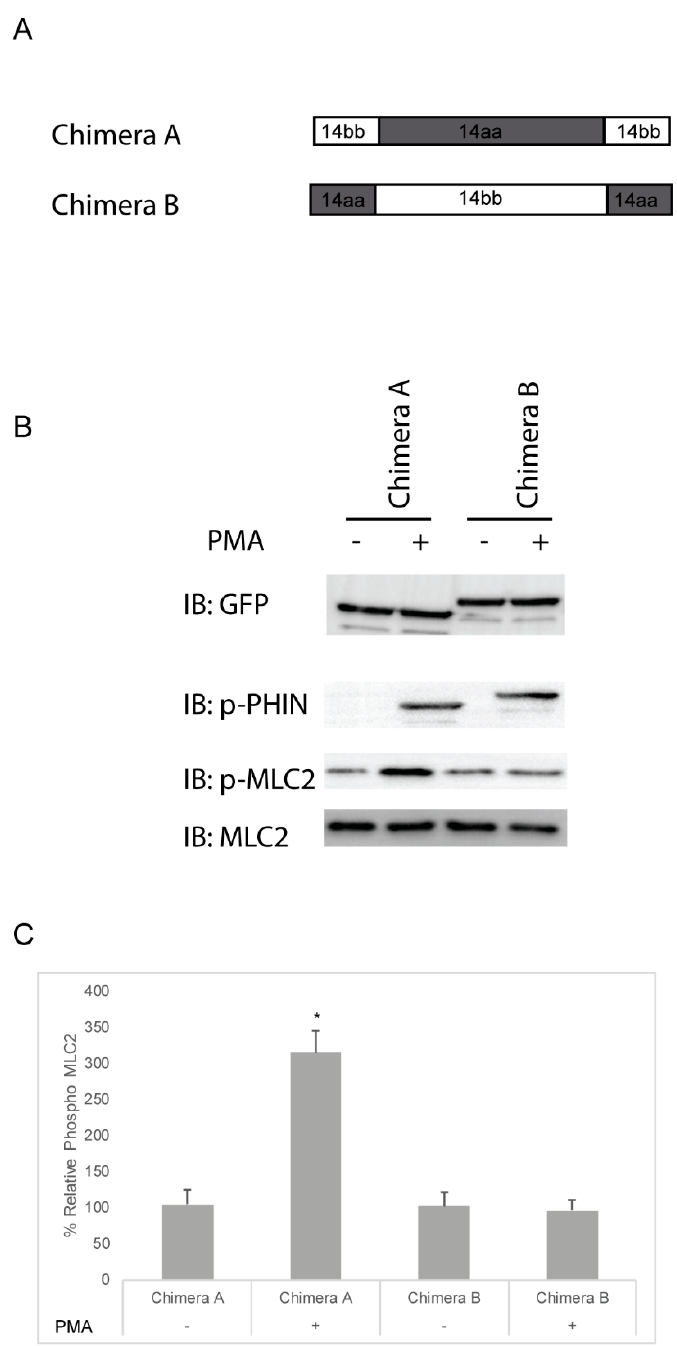
Figure 9. Cpi-17/Phi-1 chimeric proteins indicate that the PHIN domain is required for Myosin Phosphatase specificity. ( A , B ) HeLa cells were transfected with either chimera A, which contains the PHIN domain of ppp1r14aa and the N and C-termini of ppp1r14bb , or chimera B, which contains the PHIN domain of ppp1r14bb and the N and C-termini of ppp1r14aa . Notably, 15 h post transfection cells were treated with either 1 µ M PMA or 0.1% DMSO for 3 h, and lysates were blotted with anti-GFP, anti-phospho-PHIN, anti-Mlc2, and anti phospho-Mlc2. ( C ) Mlc2 phosphorylation was normalized to total Mlc2 content and is shown as fold change compared with cells expressing the empty GFP-vector. Error bars indicate standard error, and an * indicates a statistically significant di ff erence from control. Statistical significance was calculated using a one-factor ANOVA with Holm–Š í d á k post-hoc analysis and is defined as p < 0.05 from at least four biological